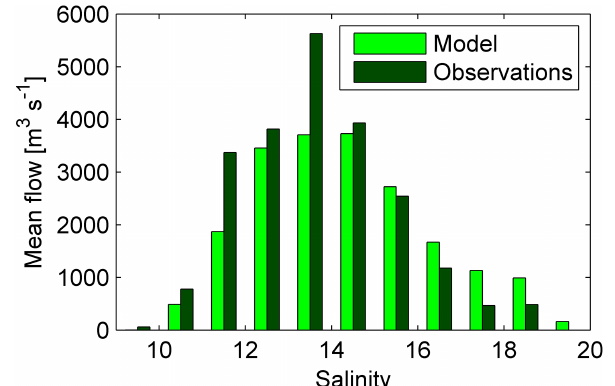
Figure 3. Distribution of observed and modeled average flow rates among different salinities for the baroclinic outflow from the Arkona Basin.